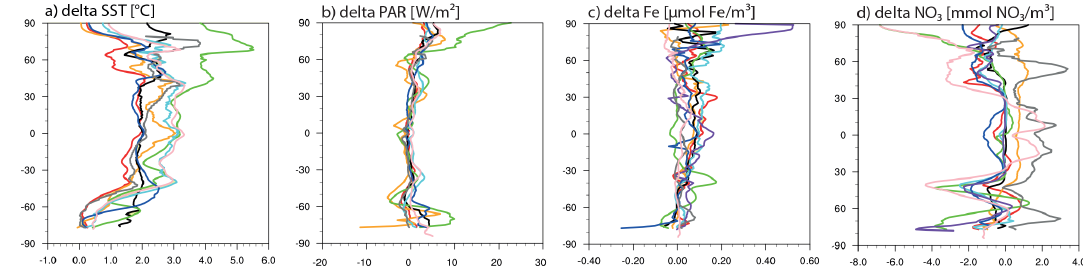
Figure 5. Zonal mean of projected sea surface temperature change, photosynthetically active radiation (PAR) change and change in surface Fe and NO 3 concentrations. We calculate the change as the difference between the 2012–2031 average and the 2081–2100 average. Different line colors denote different models, as in the legend of Fig. 2.